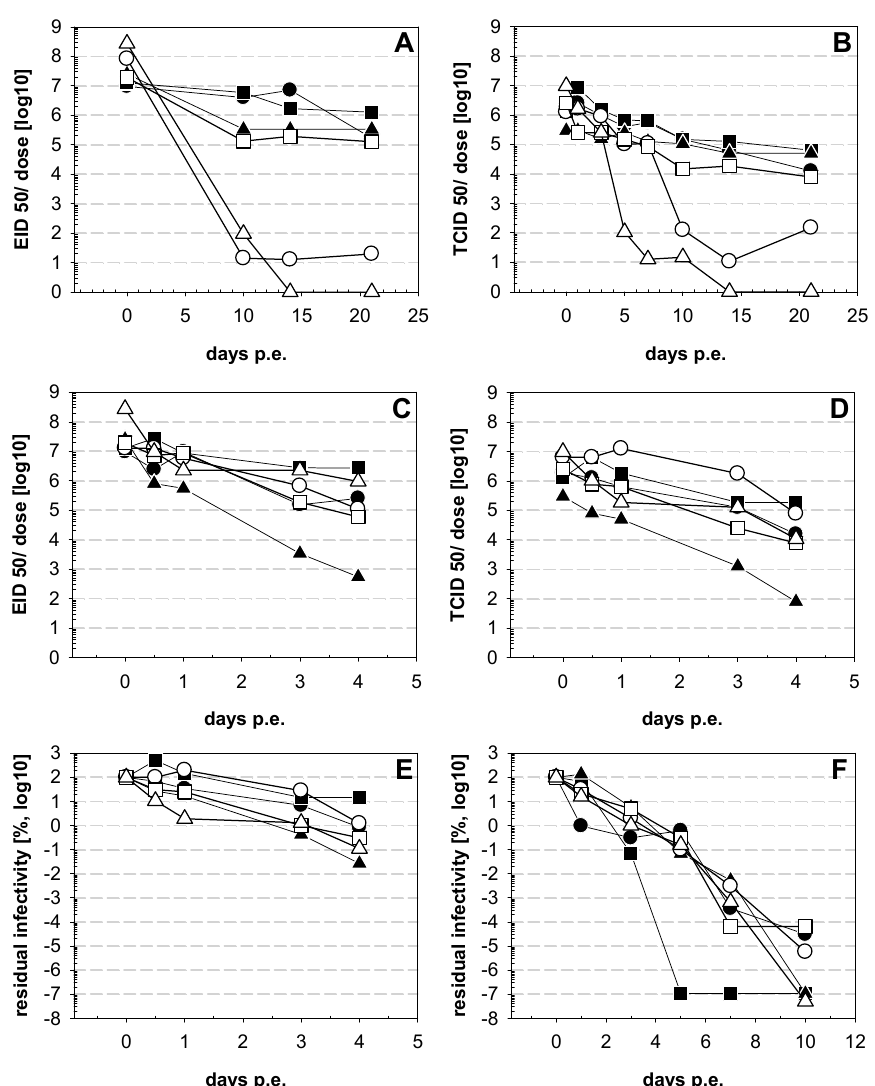
Figure 2. Stability of ND vaccine at 37 °C. ND vaccines were exposed to 37 °C in a water bath for indicated days (dpe). In the first experiments the vaccines were incubated as lyophilized materials in the original package and tested for residual infectivity using embryonatedSPF chicken eggs ( A ) or LMHcells ( B ). The second experiment tested vaccines dissolved in 2 mL ddH 2 O and determined residual infectivity with embryonatedSPF chicken eggs( C ) or LMHcells ( D ). The infectivity is nor- malized per dose of the original package. In a third set of experiments amnion-allantoic fluid (AAF) from virus stocks generated in the laboratory in embryonated SPF chicken eggs were used and tested for residual infectivity on LMH cells ( F ). To normalize results, residual infectivity is given as % of the original virus stock. For comparison, data from dissolved vaccines (C) are in- cluded as % residual infectivity ( E ). Symbols represent vaccine A ( ● ), vaccine B ( ■ ), vaccine C ( ▲ ), vaccine D ( ○ ) vaccine E ( □ ), and vaccine F ( ∆ ).